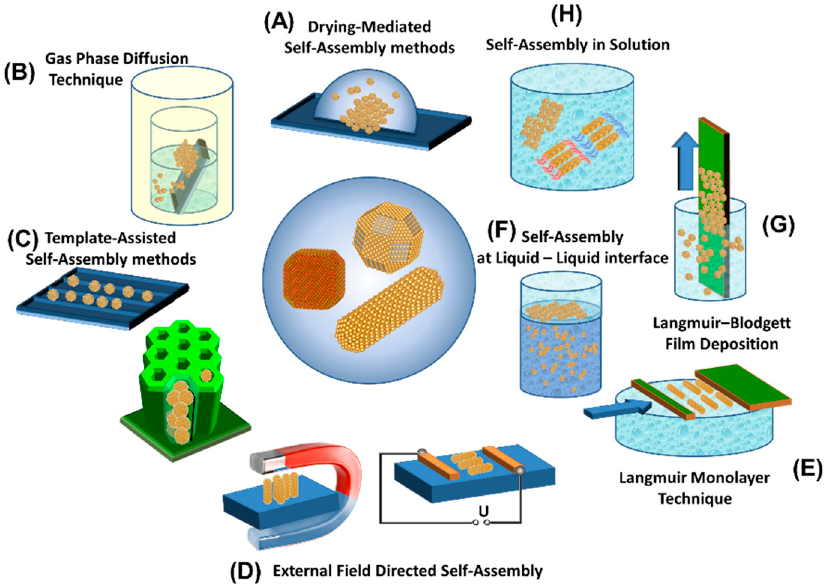
Figure 10. Schematic illustration of general methods and approaches that can be used for the fabrication of 2D and 3D nanoparticle self-assemblies (including mesocrystals).